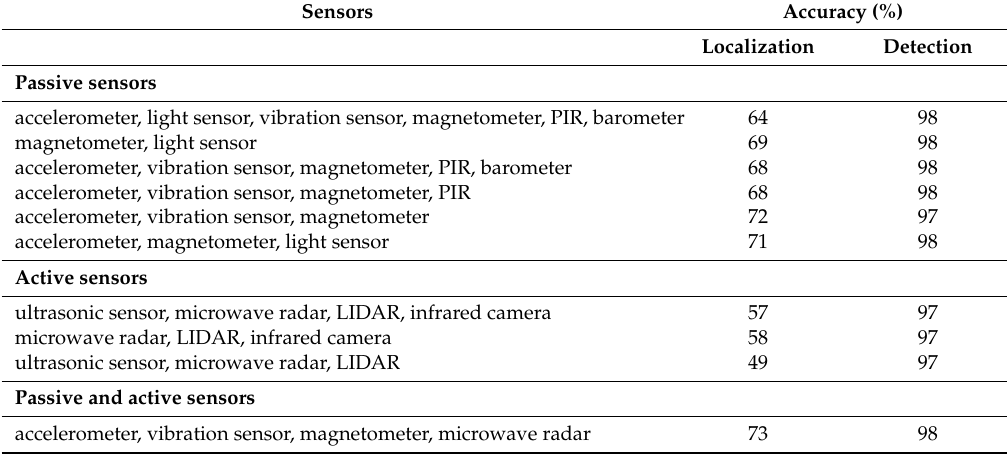
Table 9. Accuracy of vehicle detection and localization based on combined sensor readings from SN2.